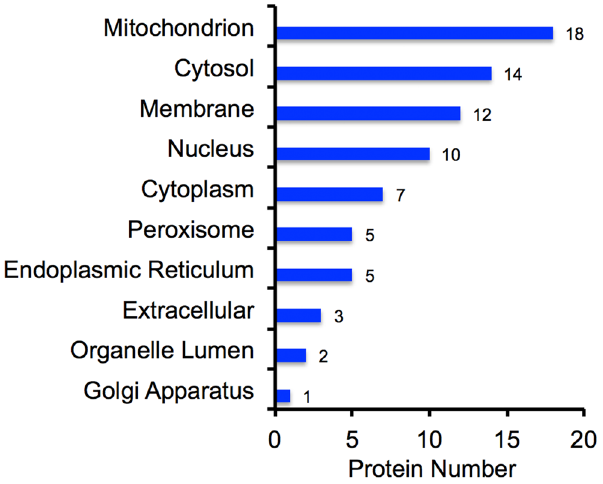
Figure 2. GO subcellular annotation for all the differentially expressed proteins in Leu-deprived HepG2 cells. Horizontal axis indicates the actual number of differentially expressed protein annotated in certain